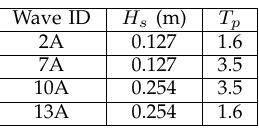
TABLE V: Wave description for objective weight matrix